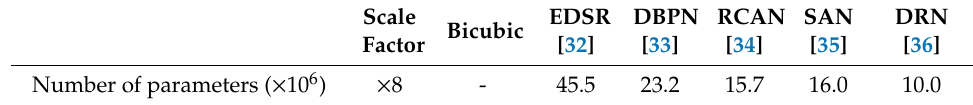
Table 5. Comparison of the number of learning parameters required for super-resolution